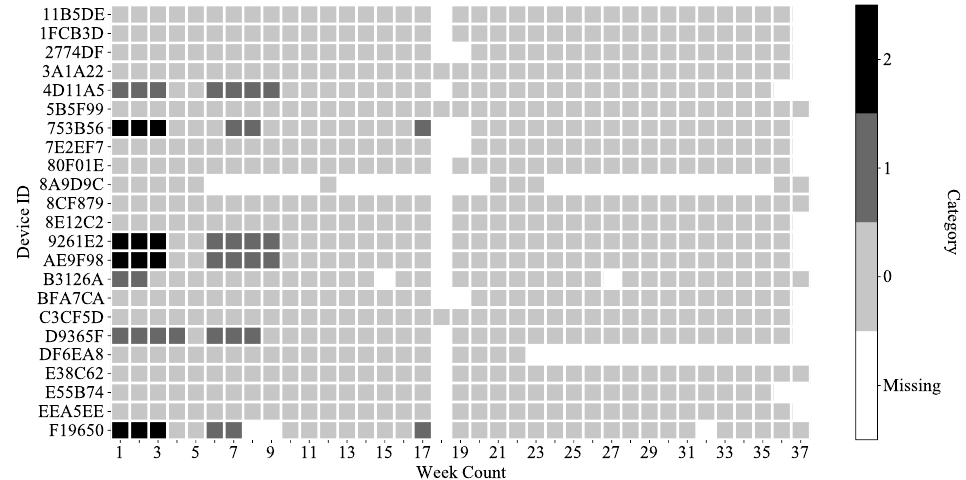
Figure 22. Cyclical components clustering result with week